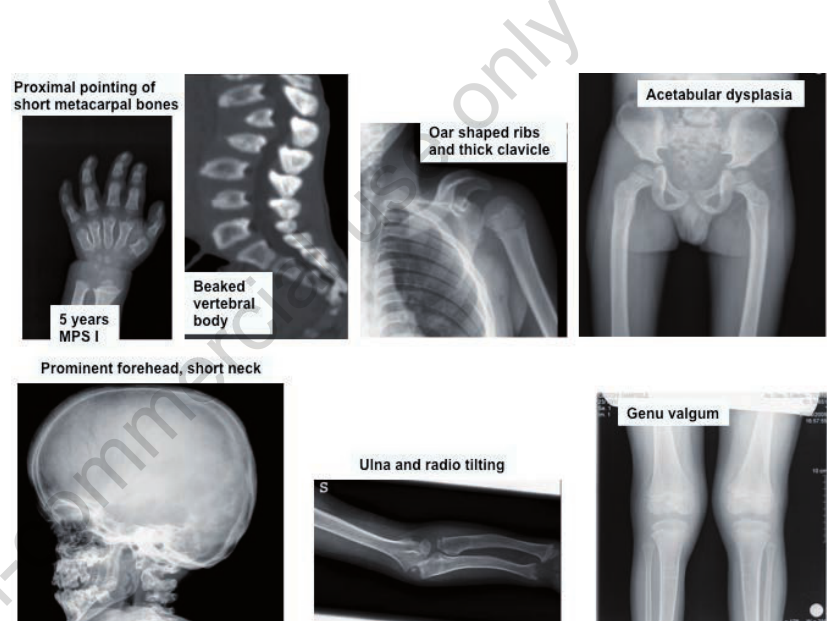
Figure 6. Generalized skeletal disease in mucopolysaccharidoses.